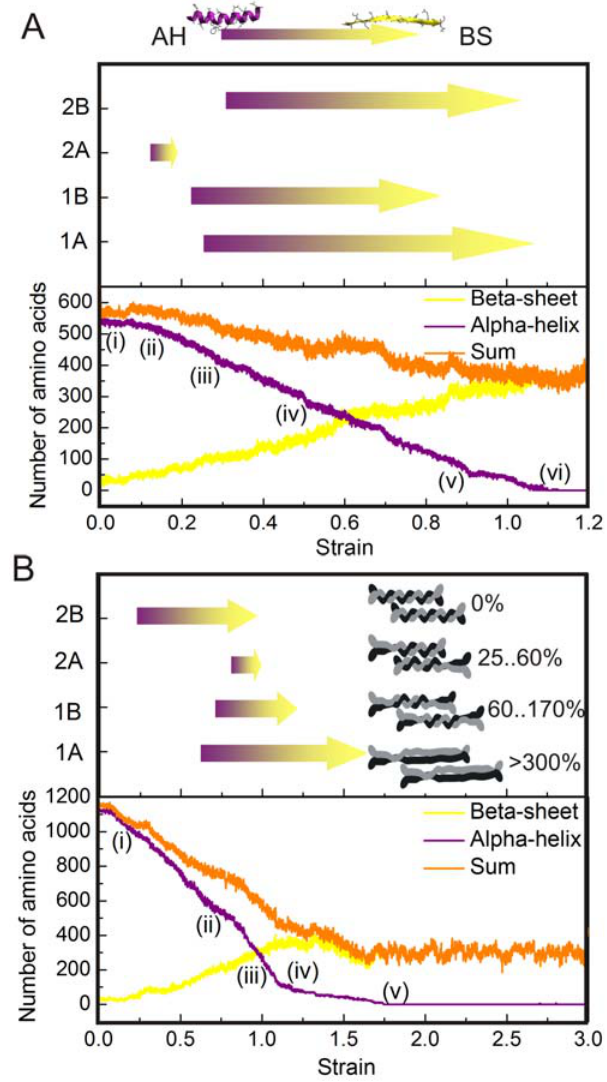
Figure 8. Geometry-strain maps for the dimer (panel A) and tetramer (panel B) structures. The lower part of the plots shows the number of amino acids associated with alpha-helical structure (purple) or beta-sheet structure (yellow), and the sum for these two known structures (orange). The arrows shown in the upper part of the plot denote processes of a - b transition for each segment. Each point marked corresponds to a snapshot with the same labels as shown in Figs. 6 and 7. The inlay in panel B shows schematics of the deformation mechanisms of the IF tetramer at various levels of strain.